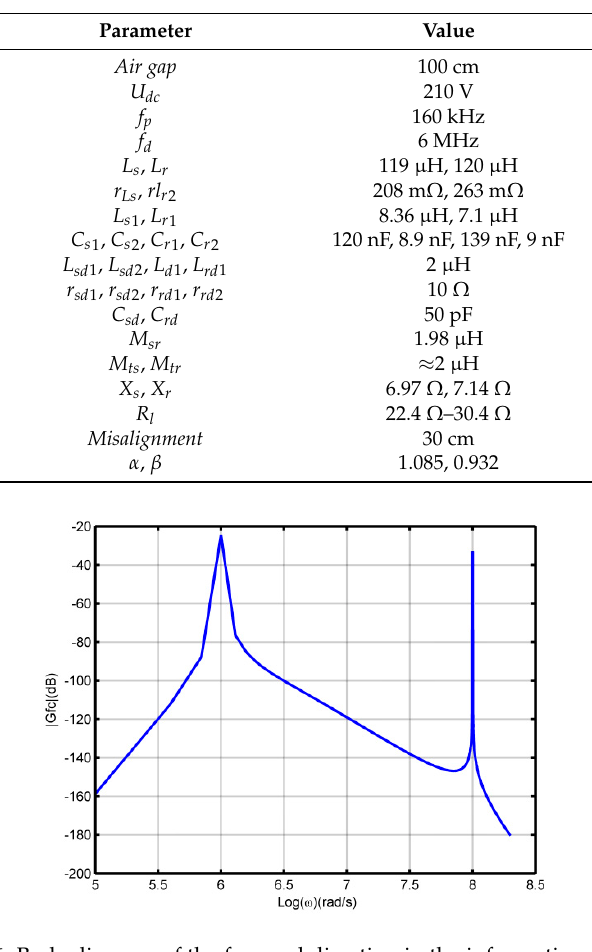
Figure 6. Bode diagram of the forward direction in the information channel.